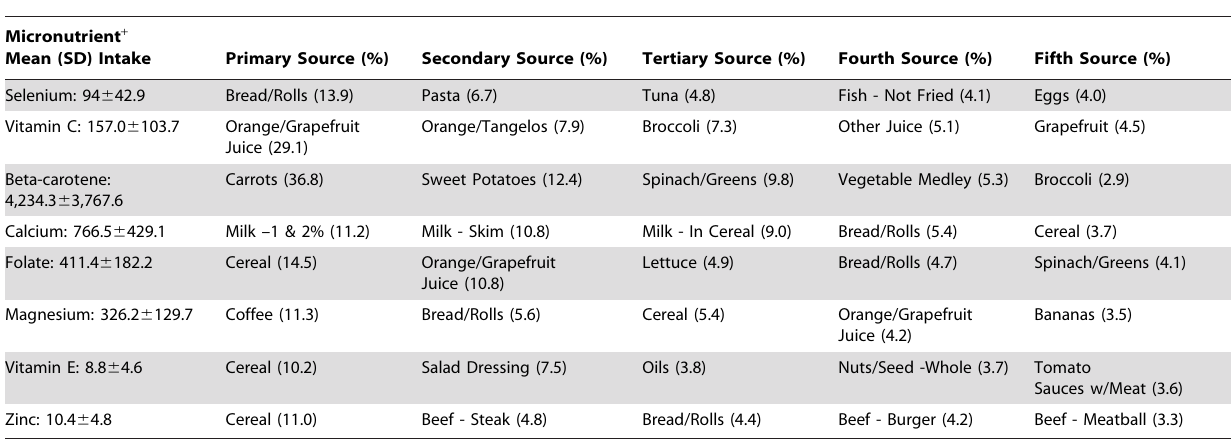
Table 2. Top Five Primary Dietary Sources for Micronutrients in NIH-AARP Diet and Health Study for Men and Women Combined.